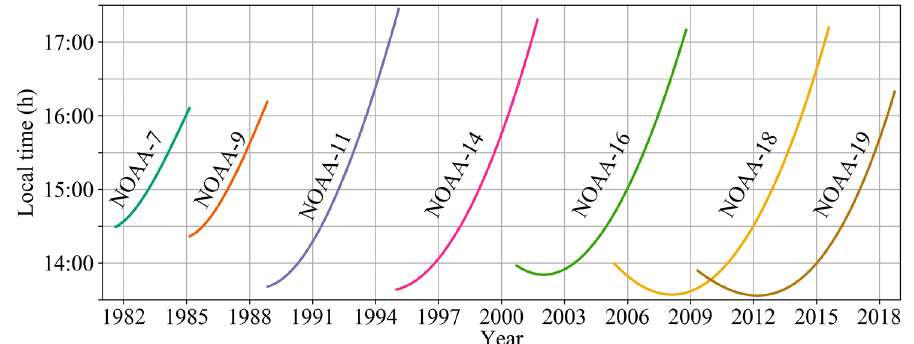
Figure 16. Equatorial crossing time (ECT) for the National Oceanic and Atmospheric Administration (NOAA)-series afternoon satellites. Figure obtained from Liu et al.